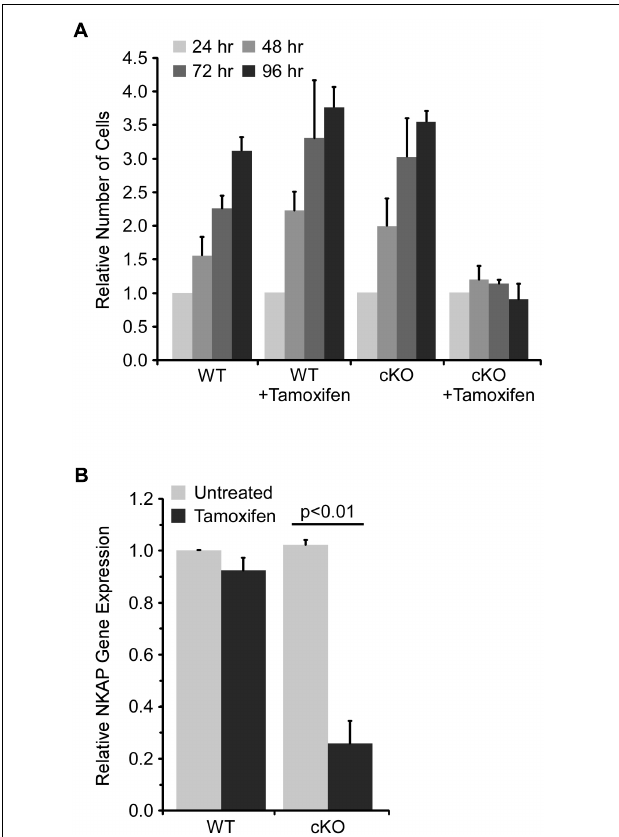
FIGURE 2 | NKAP deficiency impairs expansion of hematopoietic progenitor cultures. Hematopoietic progenitor cells were cultured ex vivo and treated with tamoxifen to induce NKAP deletion. Cells were either from mice with a floxed NKAP gene (WT) or floxed NKAP along with an ER-cre transgene (cKO). (A) The indicated cultures were treated with tamoxifen to induce NKAP deletion, or left untreated, and the number of cells in each group counted daily for 4 days. The number of cells at each time point relative to the number at 24 h is shown. The data was averaged by monitoring cultures initiated from three separate pairs of mice. (B) RNA was obtained from cells after 4 days of tamoxifen treatment and expression of NKAP was determined by RT-PCR using a Taqman gene expression assay. The data shown is average gene expression determined from four independent experiments initiated from separate pairs of mice, and normalized to the untreated WT group.